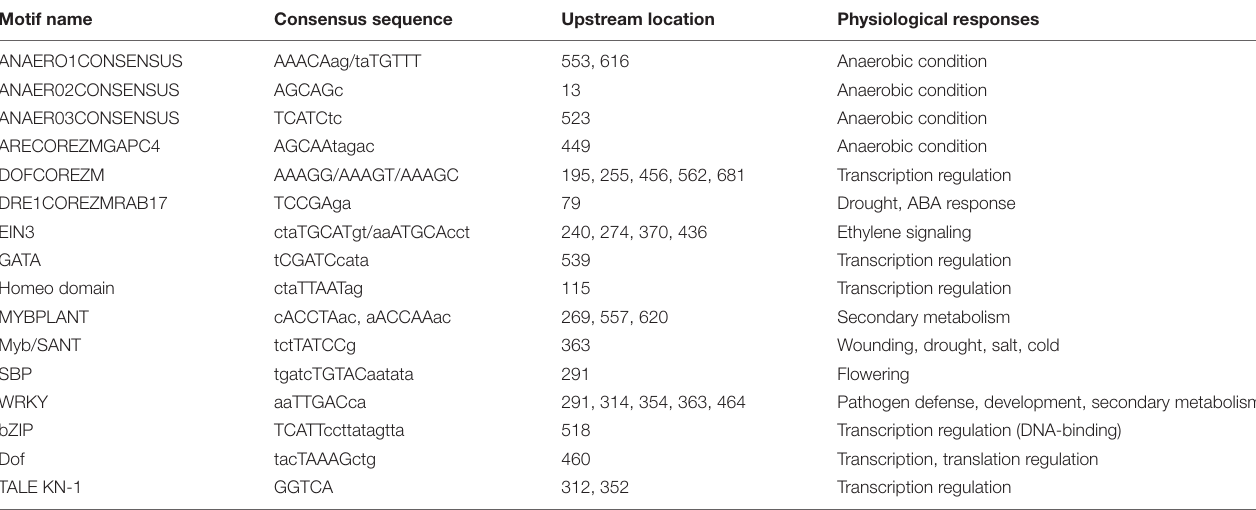
TABLE 2 | Putative transcription factor–binding site motifs present in the 700 bp upstream promoter region of the maize PRms gene 1